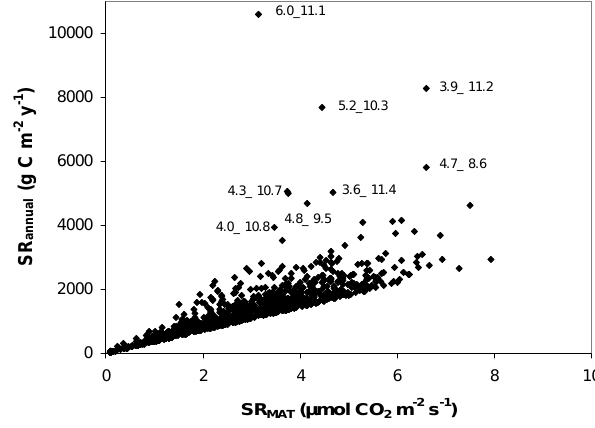
Fig. 2. Annual variation of soil temperature ( T sd ) in different cli- matic regions. Boxplots for 172 Fluxnet sites as grouped to the different bioclimatic regions. n =7, 6, 47, 49, 35, 24 and 4 for tropi- cal, dry, subtropical/Mediterranean, temperate, temperate continen- tal, boreal and arctic climates, respectively.